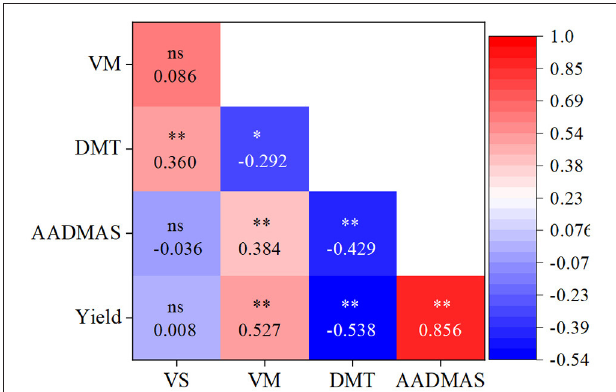
FIGURE 6 | Relationships of yield, vegetative organ dry matter at silking (VS) and at maturity (VM), and AADMAS and DMT, across all treatments, including different shading levels, cultivars, and planting densities. * P < 0.05; ** P < 0.01; ns, not